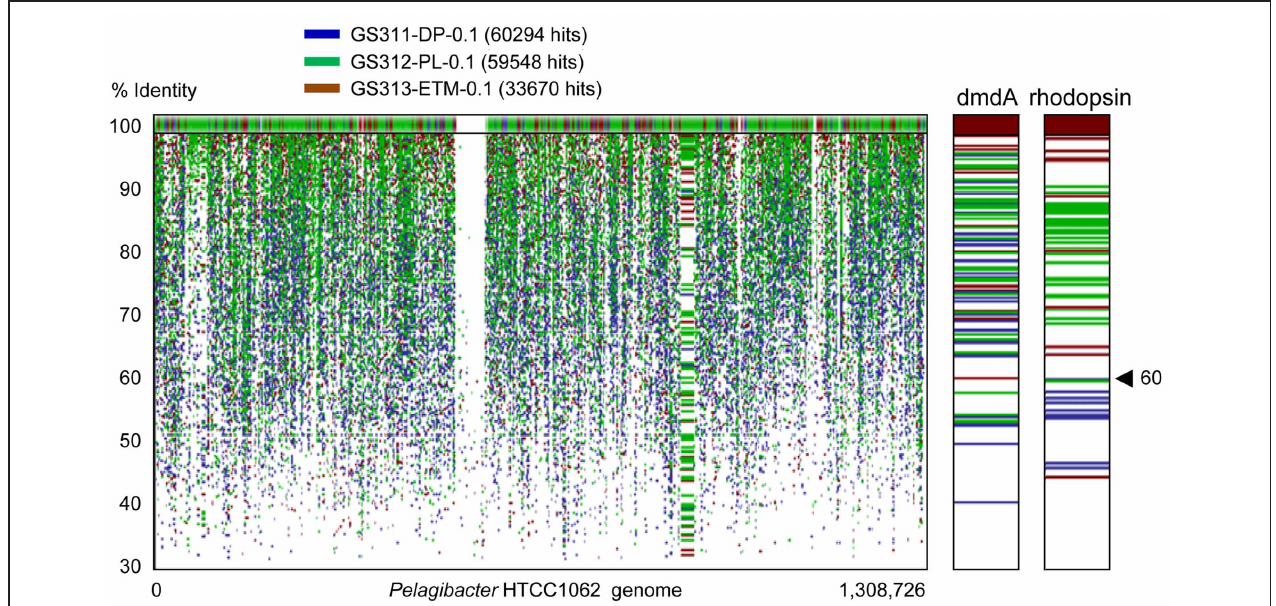
FIGURE 8 | Protein recruitment plot results showing metagenome peptide hits (with > 30% identity over > 70% of the alignment length) aligned against homologous loci of the Pelagibacter ubique HTCC1062 reference genome. The X-axis shows the hit position along the P. ubique chromosome, and the Y-axis indicates the percent identity of a given sequence alignment for a metagenome hit and the reference locus, ranging from 30 to 100%. The upper panel